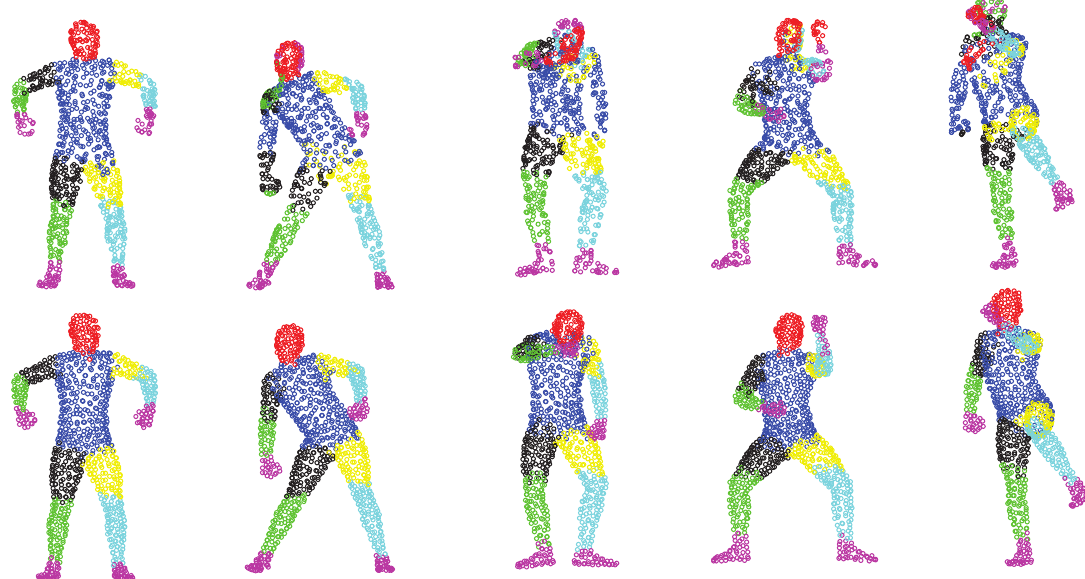
Figure 11. Correspondence estimation: coherent point drift (CPD) results (first row) and global-local topology preservation (GLTP) results (second row).